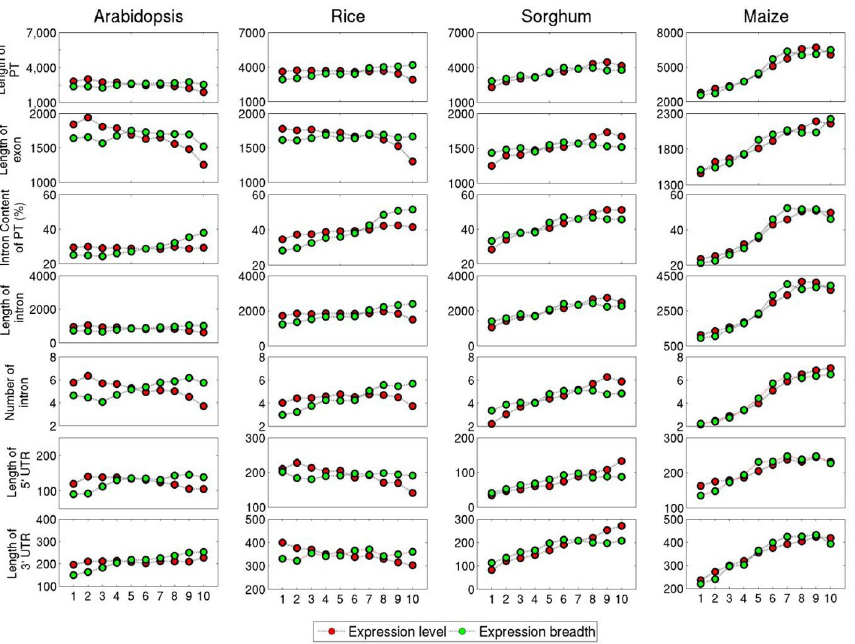
Fig 1. The relationship between 7 different length parameters of plant genes and their expression values. Each panel shows bin number (each containing 10% data) on x-axis versus the average parameter values with increase in expression level and breadth on y-axis. The dataset is divided into 10 equal bins with 10% of data in each bin. Red and green color dots represent expression level and expression breadth respectively.